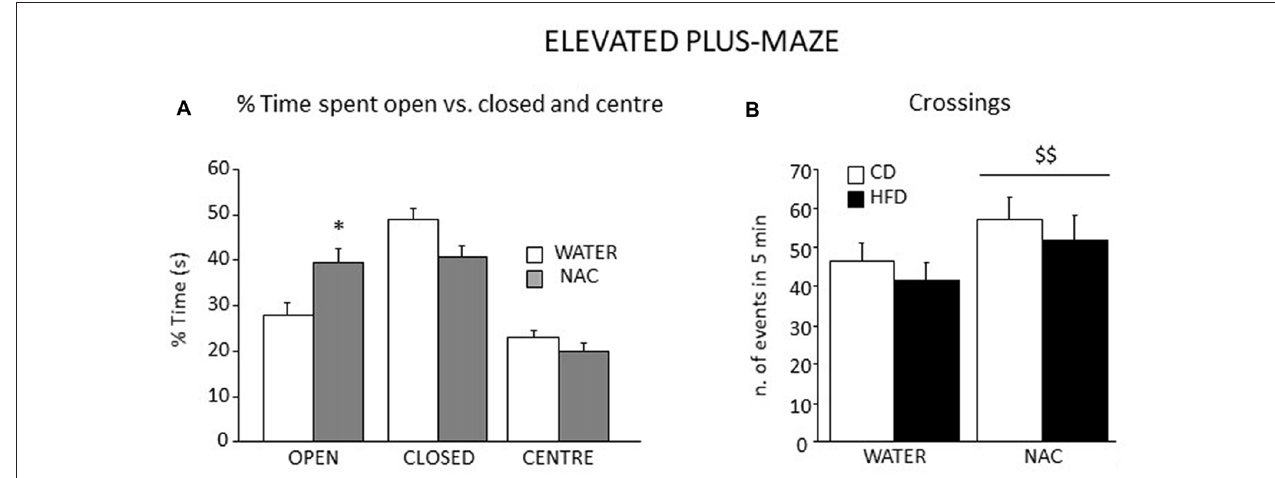
FIGURE 8 | Emotional behavior in the EPM test. All subjects spent more time in the closed arms of the maze although a significant interaction between zone and prenatal treatment revealed that NAC mice spent significantly more time in the open arms when compared to their controls (A) In addition, all NAC subjects were characterized by increased locomotion (n. of crossings, B ). Data are mean + SEM. ∗ p < 0.05, open arms: NAC vs. WATER; $$ p < 0.01, NAC vs.